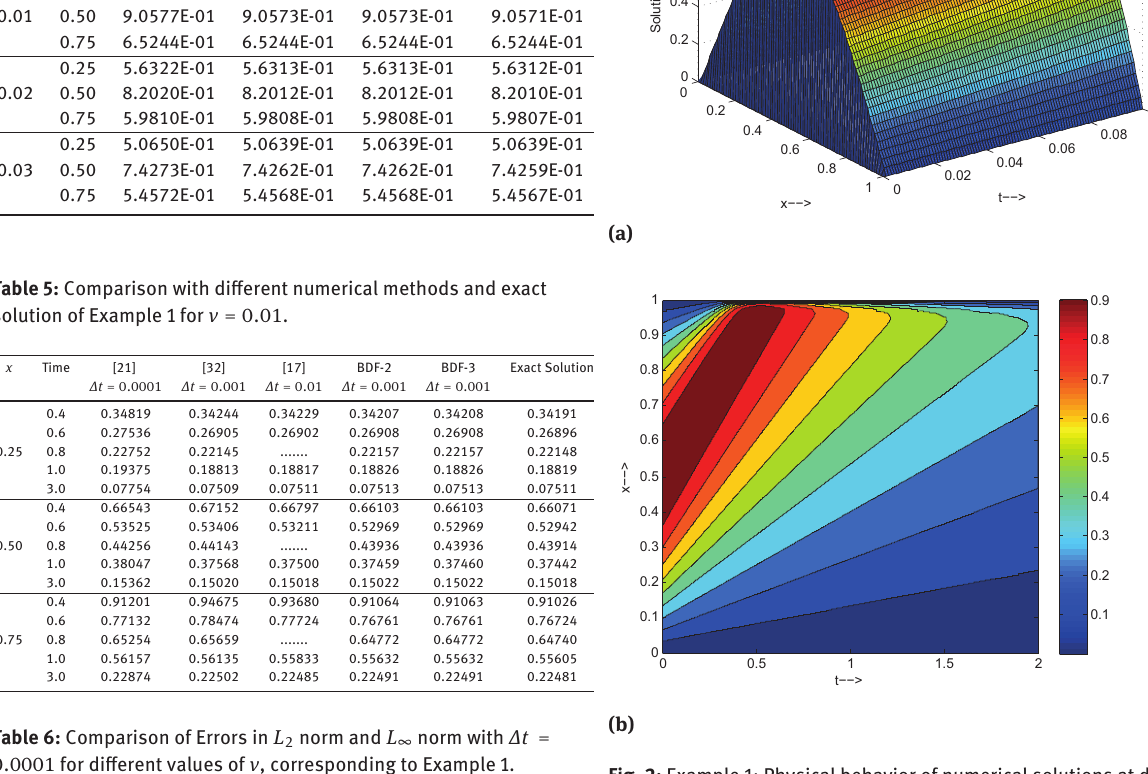
Fig. 2: Example 1: Physical behavior of numerical solutions at dif- ferent times in 3D and contour for Δx = 0.0125 , ν = 0.0066 , Δt = 0.001 (a) T = 0.1 (b) T = 2